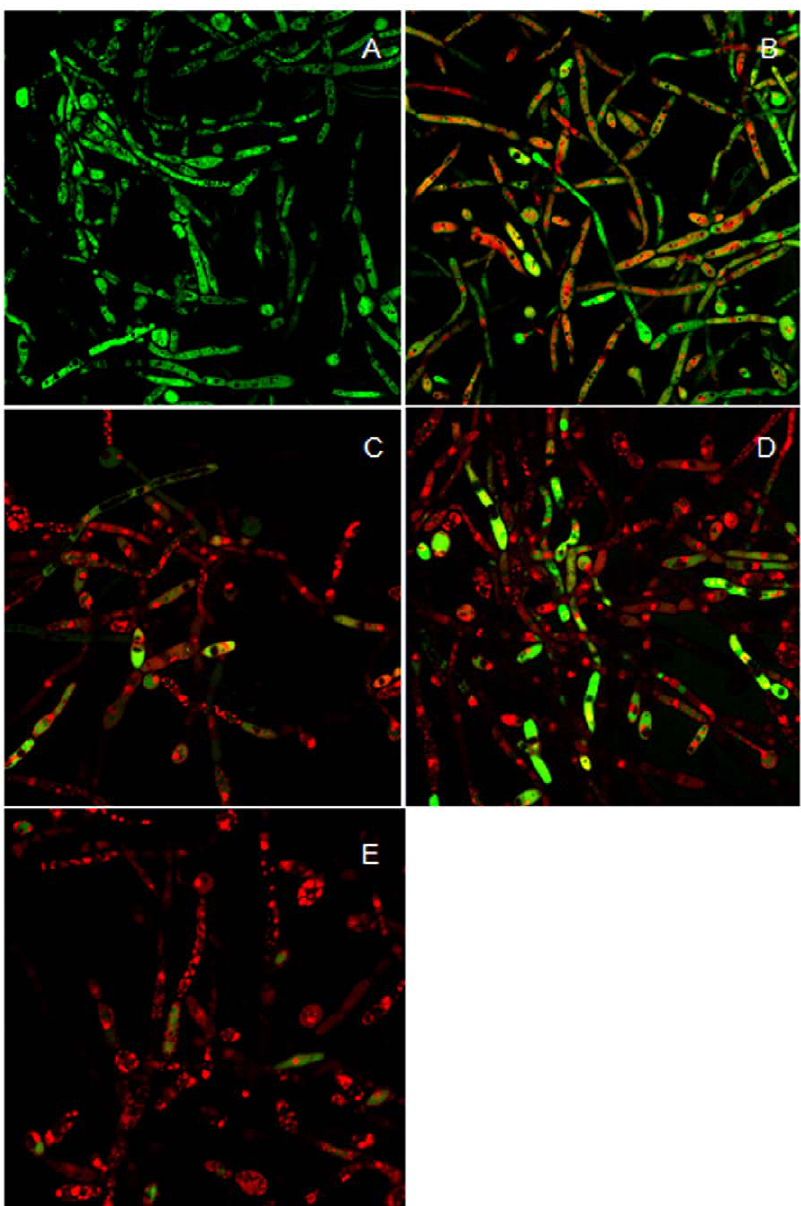
Figure 5. Confocal laser scanning microscopy images of C.albicans YEM 30 biofilms developed invivo ( 6 630). After 4 hours of C. albicans YEM 30 infection, the inoculums were removed, and riccardin D was administered alone or in combination with fluconazole and allowed to dwell in the catheters for 8 h. The specimens were removed after the animals sacrifice, washed with PBS (pH 7.4) and stained with fluorescein diacetate (FDA) and propidium iodide (PI). Cell viability could be assessed using confocal laser scanning microscopy because healthy cells with an intact membrane were stained fluorescent green, whereas those with damaged membranes stained fluorescent red. ( A ) Biofilms after 24 h of development without drug treatment; ( B ) Biofilms challenged by riccardin D at the concentration of 16 m g/ml; ( C ) Biofilms treated with riccardin D at the concentration of 64 m g/ml; ( D ) Biofilms treated with fluconazole at the concentration of 4 m g/ml; ( E ) Biofilms treated with riccardin D (16 m g/ml) and fluconazole (4 m g/ml) when used in